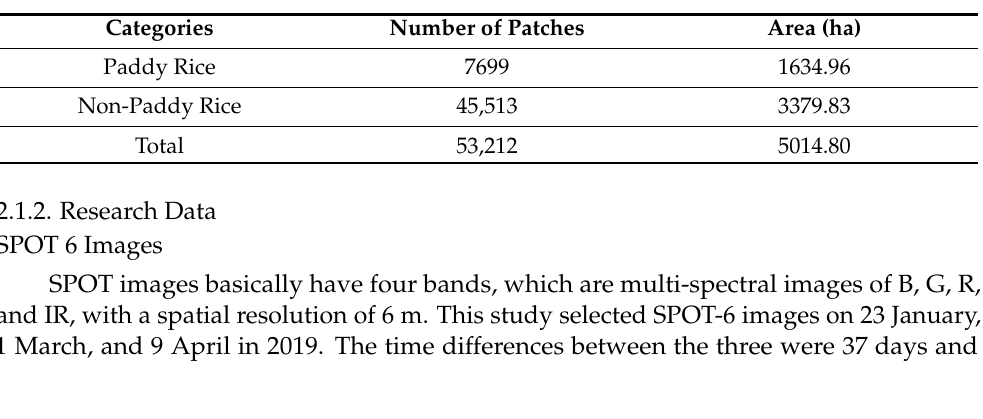
Figure 2. The patches are taken from the photo in 2019. ( a ) Farmland patches in study area. ( b ) The ground truth data from the Agriculture and Food Agency. Table 1. The ground truth data of Xiluo in 2019.